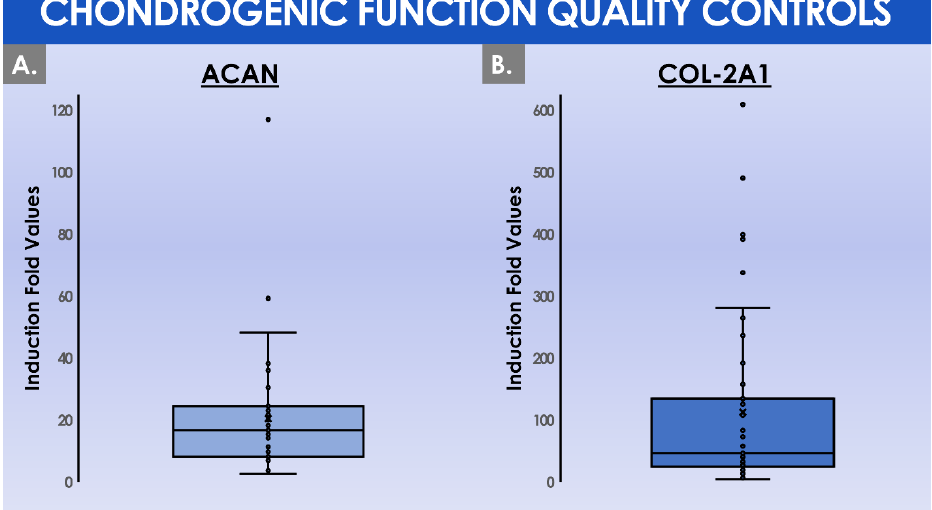
Figure 6. Comparative quantitative results of functional parameter (i.e., chondrogenic gene evolutive expression levels) QC assays for the cellular APIs, outlining inter-patient variability. ( A ) Induction fold values for the Acan gene expression upregulation (i.e., using the ∆∆ CT method) between day 1 (i.e., baseline) and day 16 (i.e., endpoint) of three-dimensional cell cultures in chemically induced chondrogenic conditions. ( B ) Induction fold values for the COL2A1 gene expression upregulation between day 1 and day 16 of three-dimensional cell cultures in chemically induced chondrogenic conditions. The quantitative data from the functional QC assay were presented for 42 patients. Several patients were excluded from the analysis due to a change in the chondrogenic medium composition. API, active pharmaceutical ingredient; QC, quality